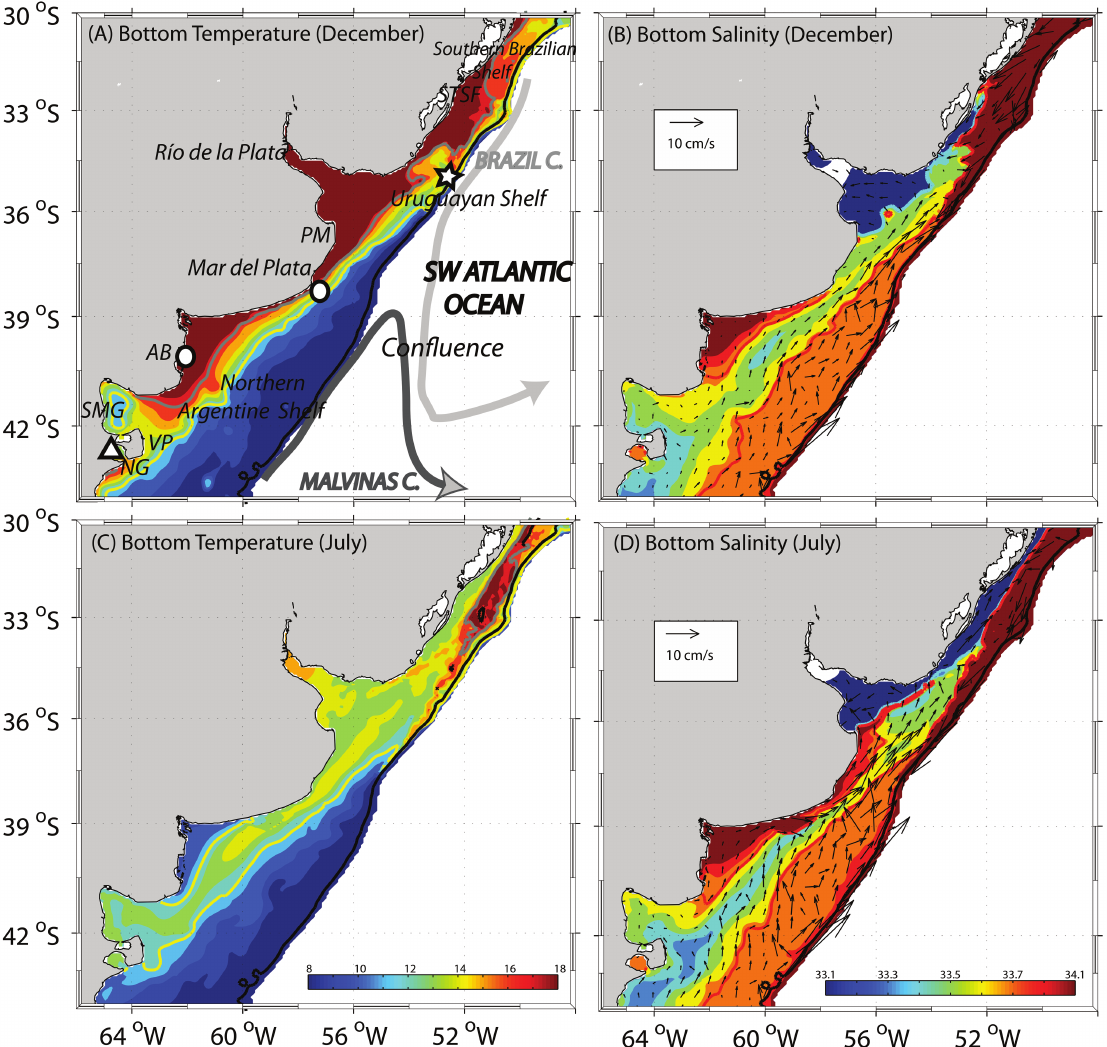
Fig. 1. Schematic representation of the depth-averaged ocean circulation in the Southwestern Atlantic Ocean (adapted from Matano et al ., 2010) showing the geographical locations of tagging of Galeorhinus galeus [Triangle, Nuevo Gulf (NG), 42°30’S, 65°55’W, depth 100 m], newest recapture in Uruguayan shelf waters (Star, 35°30’S, 51°48’W – depth 290 m) and the two old recapture sites (Circle, Mar del Plata, 38°24’S, 57°18’W, depth 40 m and Canal Culebra, 40°24’S, 62°06’W - depth 15 m, Irigoyen et al ., 2015). Additional geographical locations are indicated with acronyms: SMG = San Matías Gulf, VP = Valdés Peninsula, AB = Anegada Bay, PM = Punta Médanos, STSF = Subtropical Shelf Front. The thick curved lines represent the path of the major ocean currents. The black line is the 200m isobath. Colours indicate bottom temperature (a, c) and bottom salinity (b, d) and black arrows indicate the bottom shelf circulation extracted from a numerical model (Palma et al ., 2008). The yellow and gray lines in the left panels indicate the 11 and 17 °C isotherms respectively. The red and cyan lines in the right panels indicate the 33.93 and 33.5